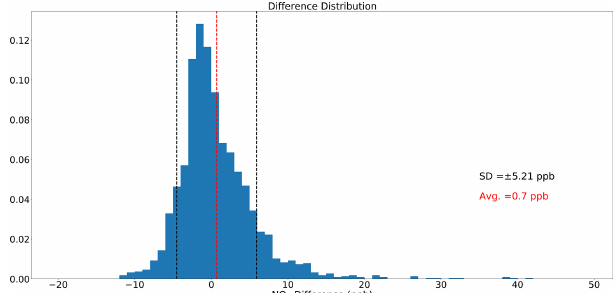
Figure 3. The distribution of the differences in between the inferred daily average concentrations and 24h average concentrations mea- sured by LfU stations. Bin width is 1ppb. Evaluated stations includ- ing Allach, Johanneskirchen and